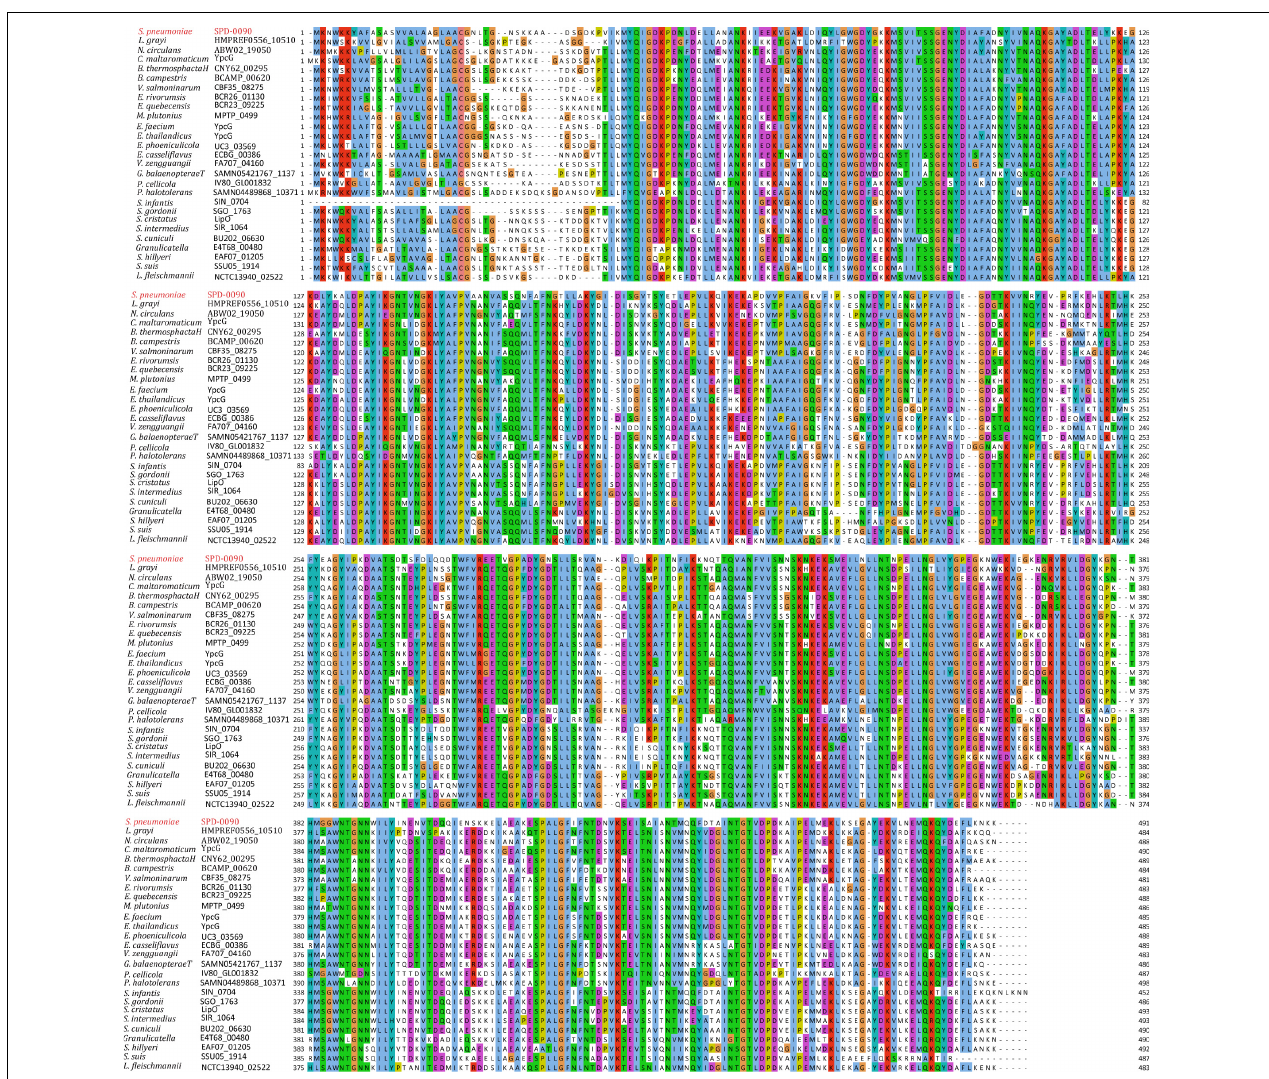
FIGURE 1 | The multiple sequence alignment of SPD_0090 with homologous proteins in various bacterial